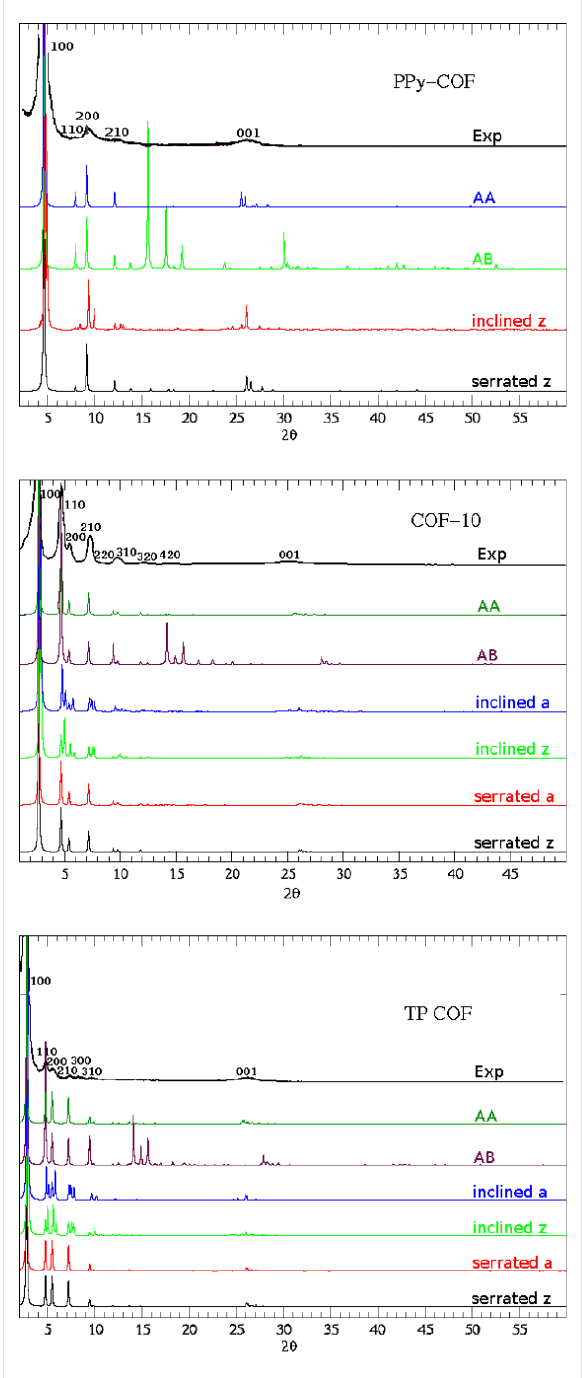
Figure 4: The calculated and experimental [8,13,14] XRD patterns of PPy-COF (top), COF-10 (middle) and TP COF (bottom).